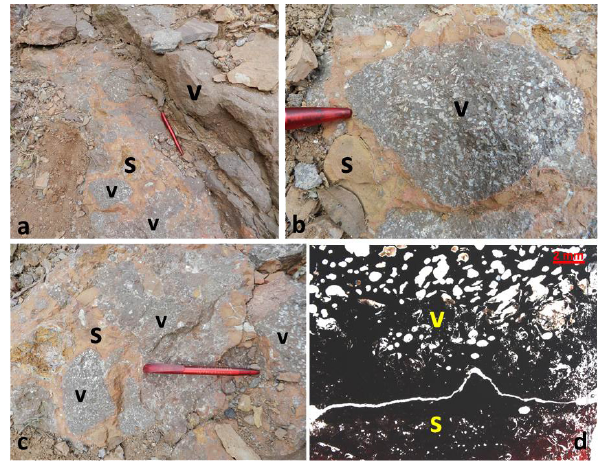
Fig. 11. Peperite from the stratigraphically higher level on the sec- tion exposed in the Rota do Sol highway: green to pale volcanic clasts, displaying sub-angular to irregular morphologies, set in a reddish-brown siltstone matrix, which also fills vesicles in volcanic clasts (yellow arrows in d